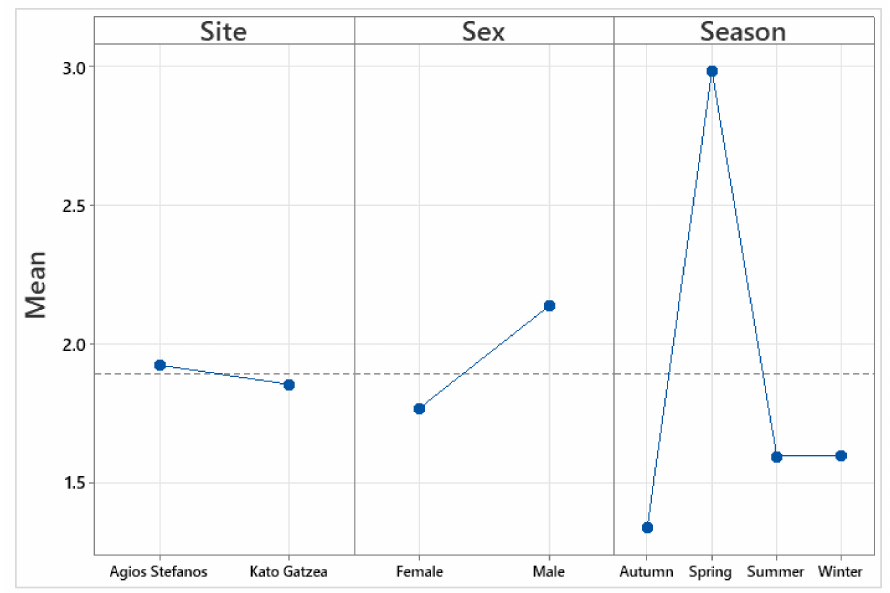
Figure 8. Main effects plot of the influence that spatial (site), phyletic (sex) and temporal (season) factors exert on the GSI.